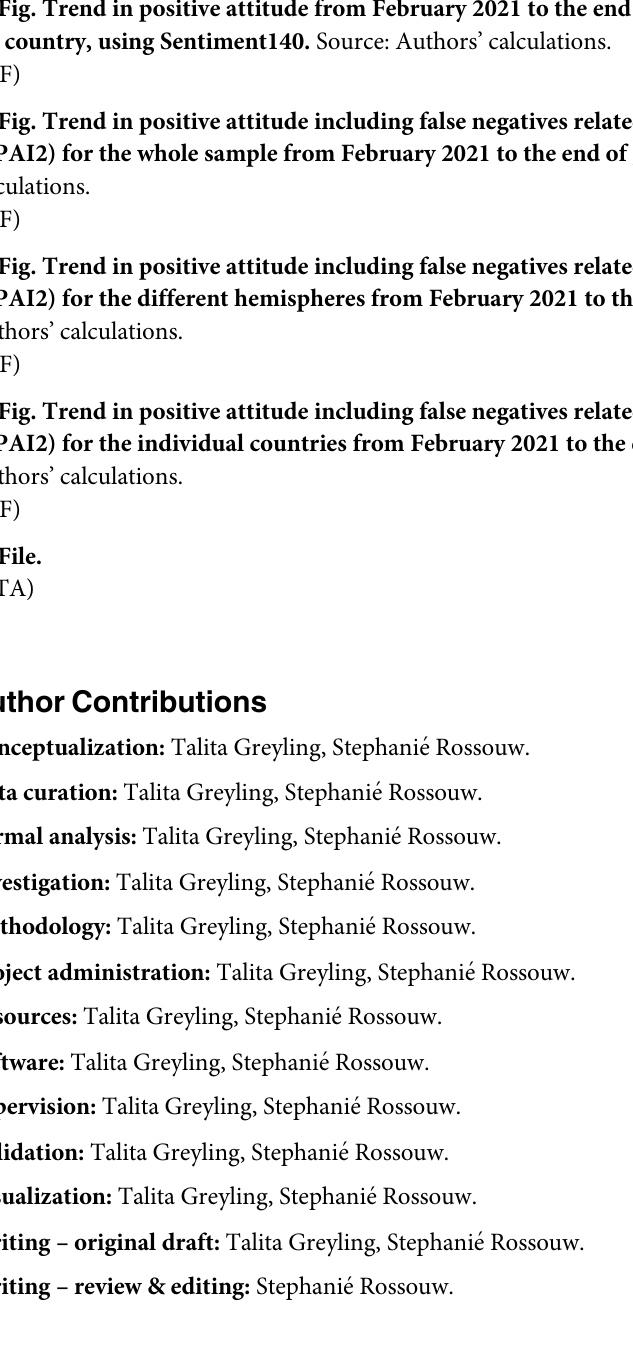
S2 Fig. Trend in positive attitude from February 2021 to the end of July 2021 per hemi- sphere, using Sentiment140. Source: Authors’ calculations. S3 Fig. Trend in positive attitude from February 2021 to the end of July 2021 per individ- ual country, using Sentiment140. Source: Authors’ calculations. S4 Fig. Trend in positive attitude including false negatives related to governments (VPAI2) for the whole sample from February 2021 to the end of July 2021. Source: Authors’ calculations. S5 Fig. Trend in positive attitude including false negatives related to governments (VPAI2) for the different hemispheres from February 2021 to the end of July 2021. Source: Authors’ calculations. S6 Fig. Trend in positive attitude including false negatives related to governments (VPAI2) for the individual countries from February 2021 to the end of July 2021. Source: Authors’